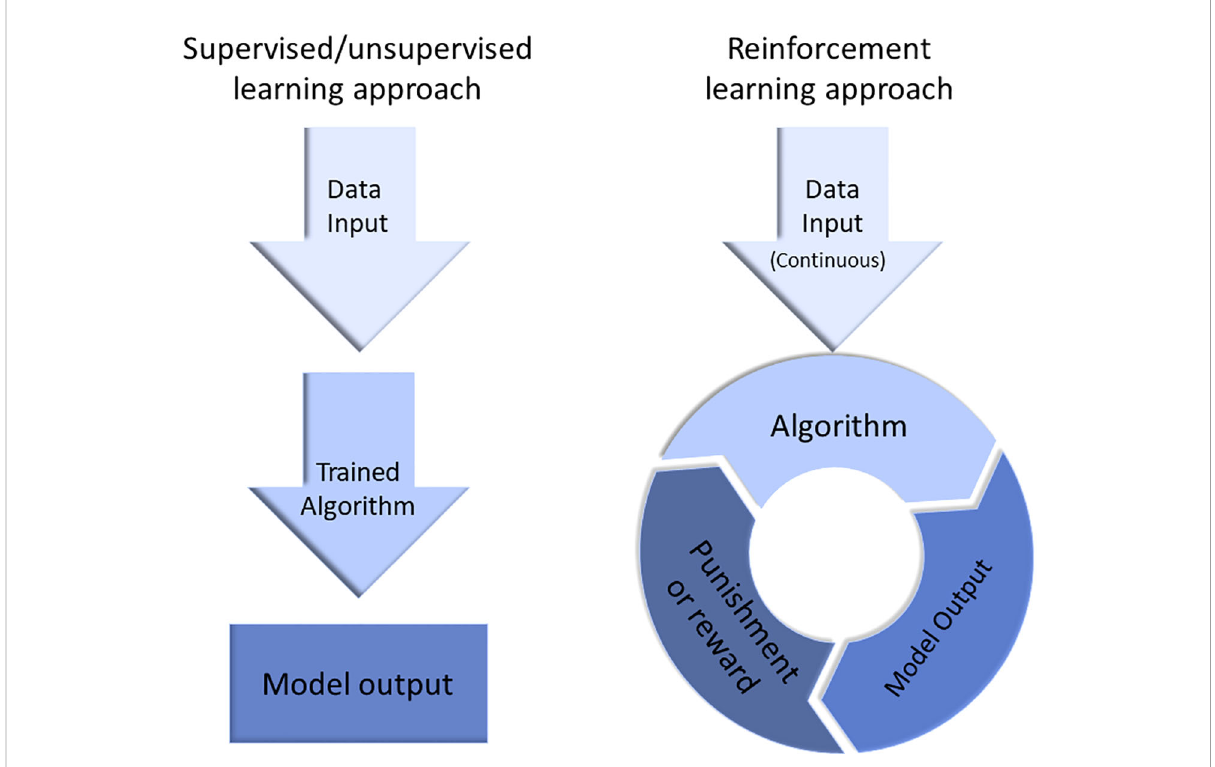
FIGURE 3 Traditional machine learning techniques improve prediction accuracy by incorporating more training data for the model to learn. Conversely, deep reinforcement learning allows models to improve by incorporating more data through their continued exposure to their environment and by rewarding or punishing correct and incorrect actions,